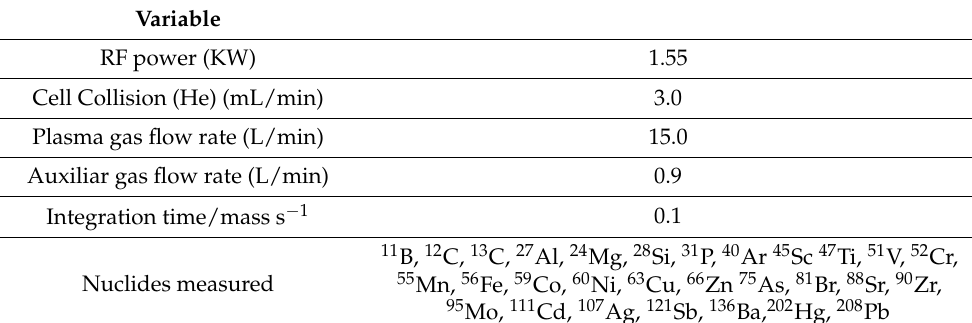
Table 2. ICP-MS operating